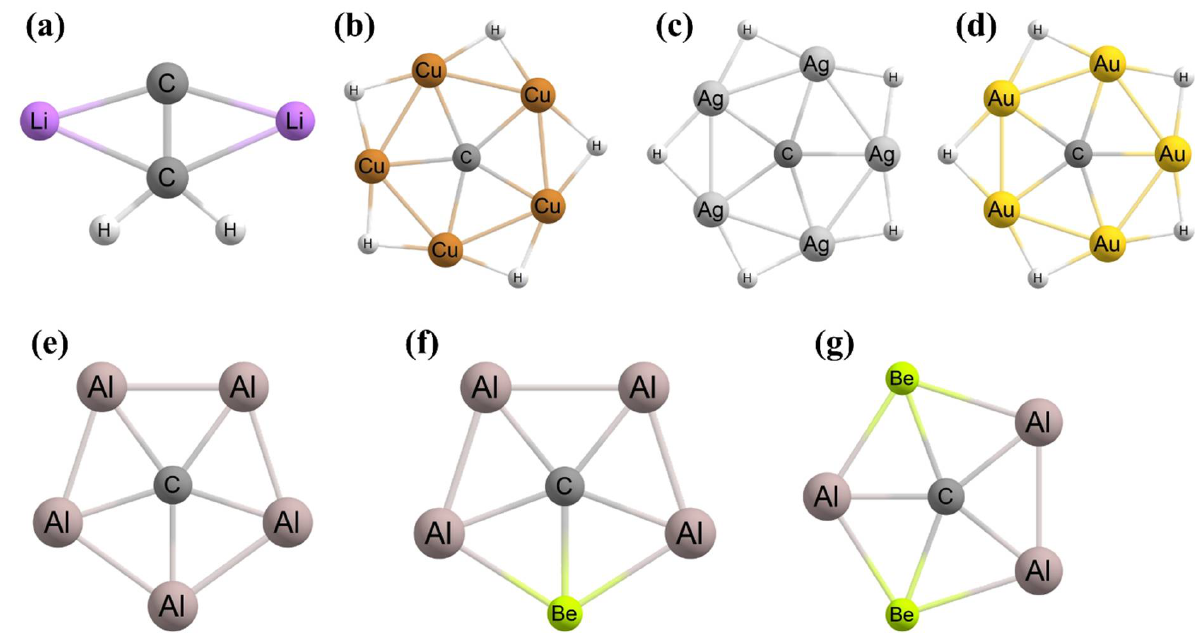
Figure 18. ( a ) A C 2 v -symmetric ppC-containing isomer of 1,1-dilithioethene contains two bridging Li centers. The computed structures of ( b ) Cu 5 H 5 C, ( c ) Ag 5 H 5 C, and ( d ) Au 5 H 5 C each feature bridging hydrides and a ppC. The global minimum energy structures of ( e ) CAl 5+ , ( f ) CAl 4 Be, and ( g ) CAl 3 Be 2− clusters.